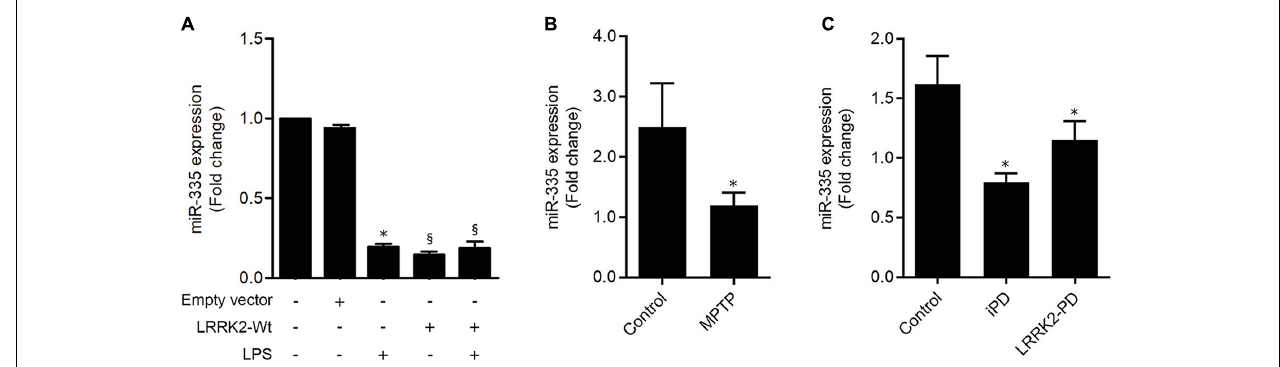
FIGURE 1 | miR-335 is reduced in in vitro and in vivo experimental models of PD and in the sera PD patients. (A) qRT-PCR analysis of miR-335 in BV2 microglial cells transfected with LRRK2-Wt overexpression plasmid, or empty vector, for 24 h and then stimulated with 100 ng/mL LPS for additional 24 h. (B) qRT-PCR analysis of miR-335 in the sera of MPTP-injected mice or control mice, euthanized at 30 days after MPTP injection. Values were normalized to the mean of control mice. (C) qRT-PCR analysis of miR-335 in serum of iPD and LRRK2-PD patients and control individuals. Values were normalized to the mean of control healthy individuals. Results are expressed as mean ± SEM. ∗ p < 0.05 vs. Control; p < 0.05 vs. control Empty